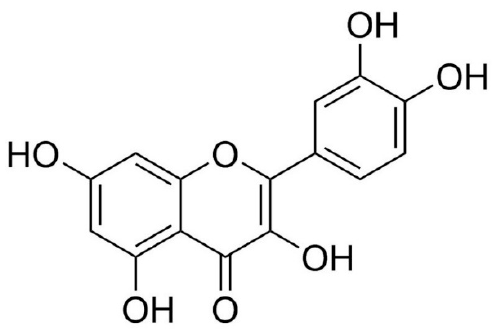
Figure 7. Chemical structure of quercetin (3,5,7,3 ′ ,4 ′ -pentahydroxyflavone).